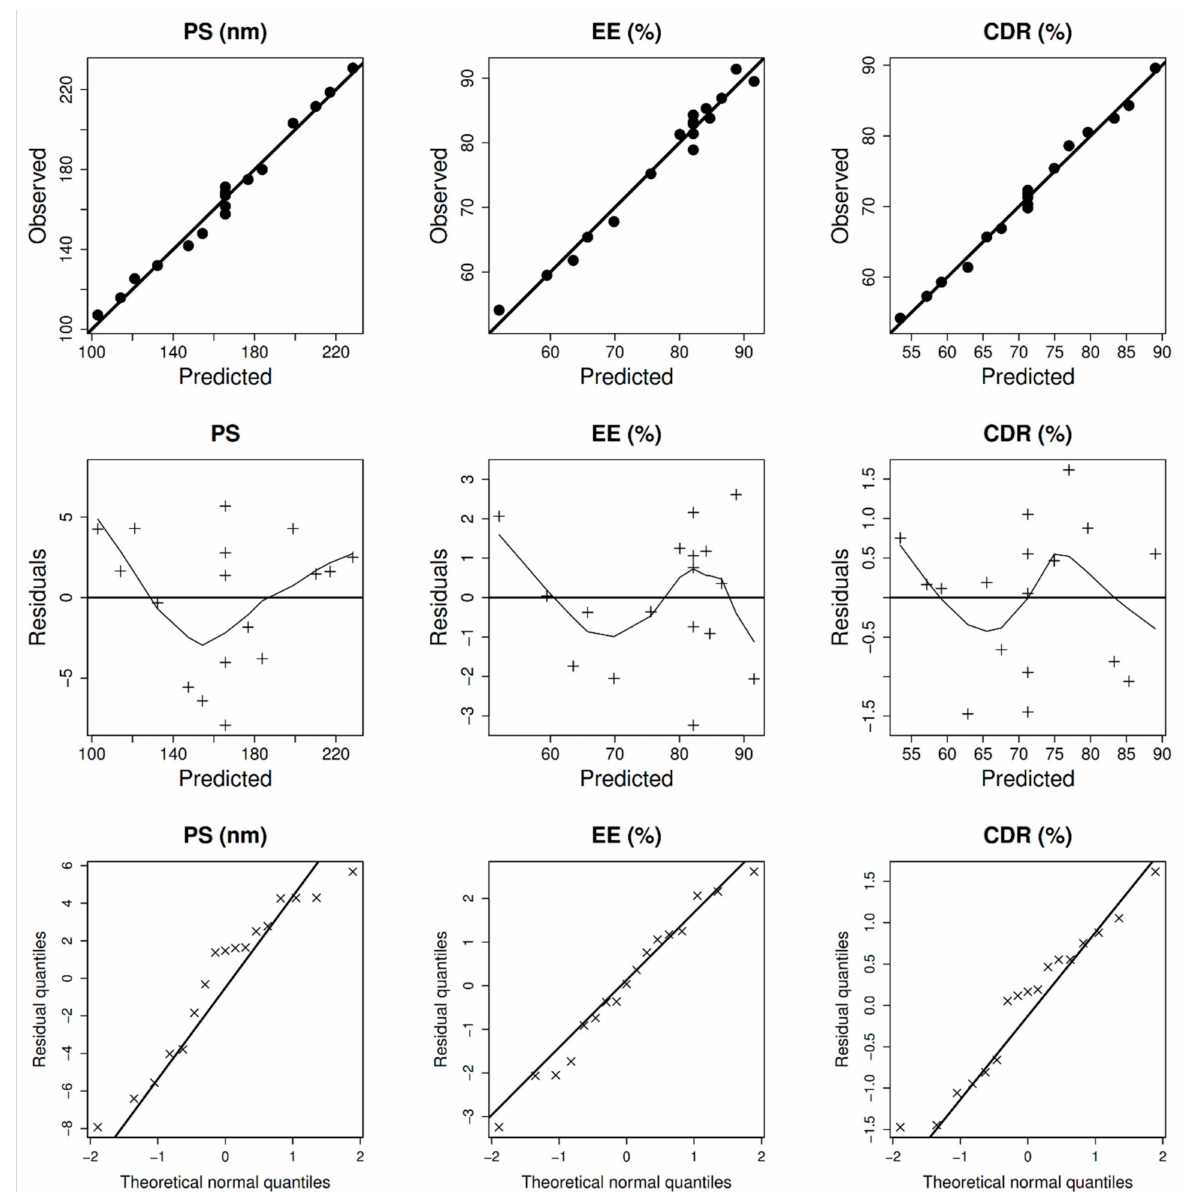
Figure 1. Model diagnostics plots of BER-NLCs size (PS), entrapment (EE%), and cumulative drug released